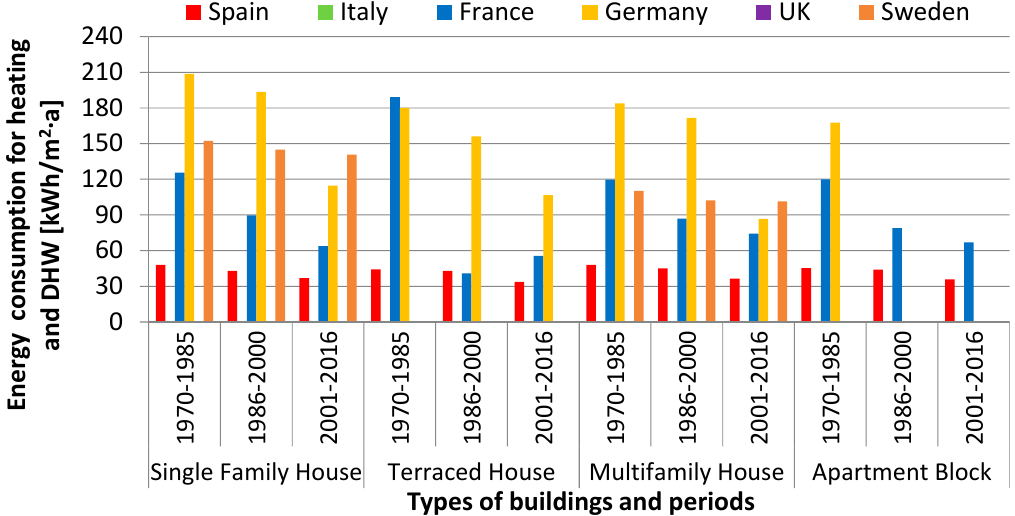
Figure 5. Energy consumption for heating and domestic hot water in hot climate conditions by country.